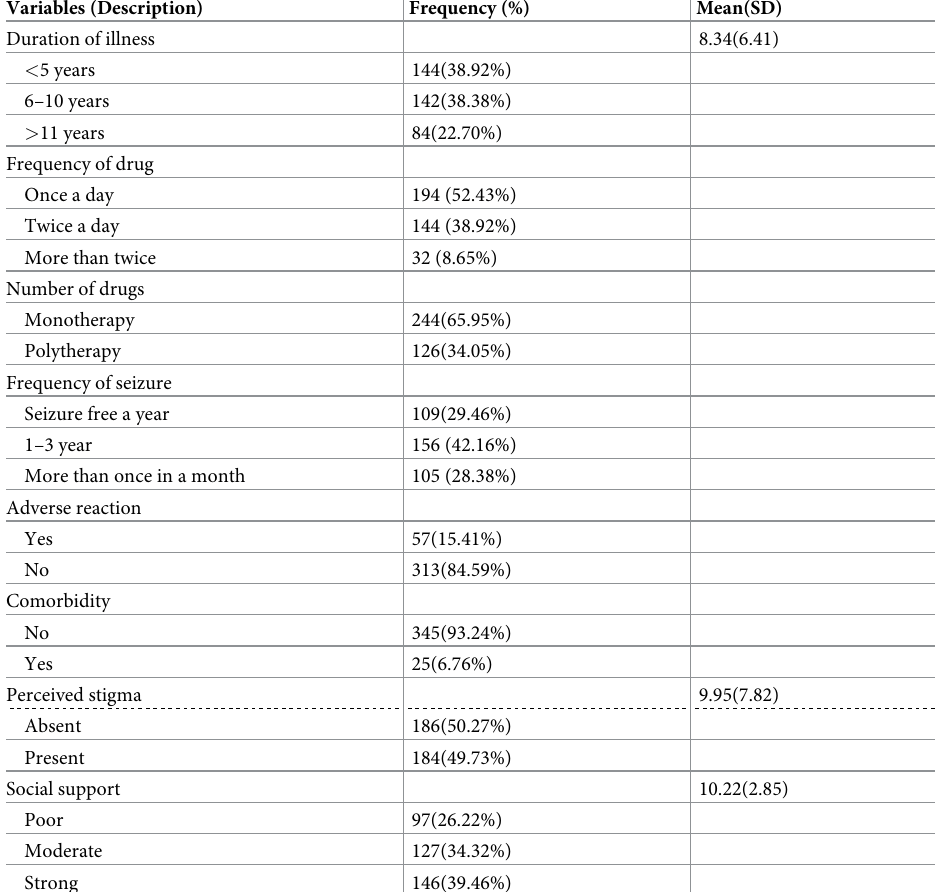
Table 2. Clinical and modifying characteristics of the study participants (n = 370) in Gondar Specialized Hospital, Gondar town, Northwest Ethiopia,